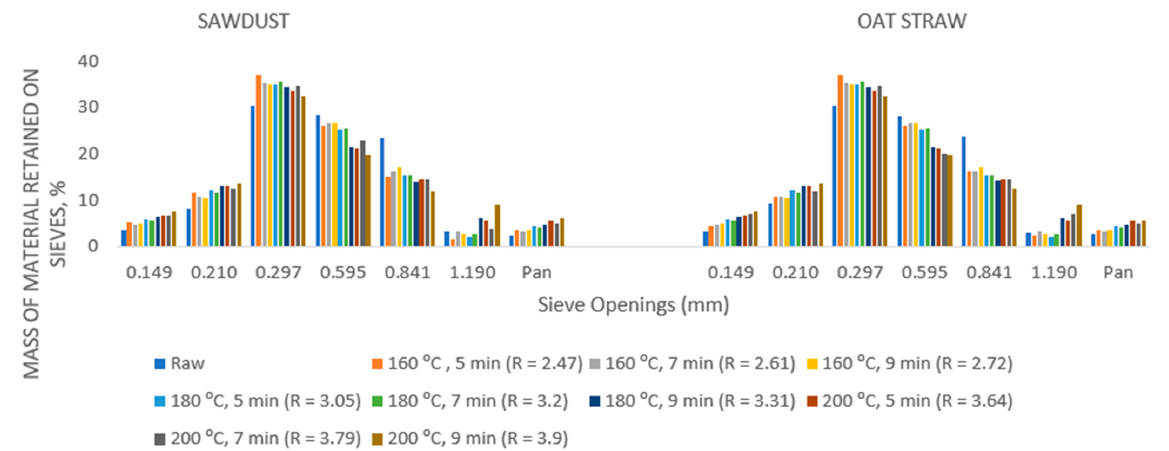
Figure 2. Size distribution of the untreated and treated sample particles at different severities.